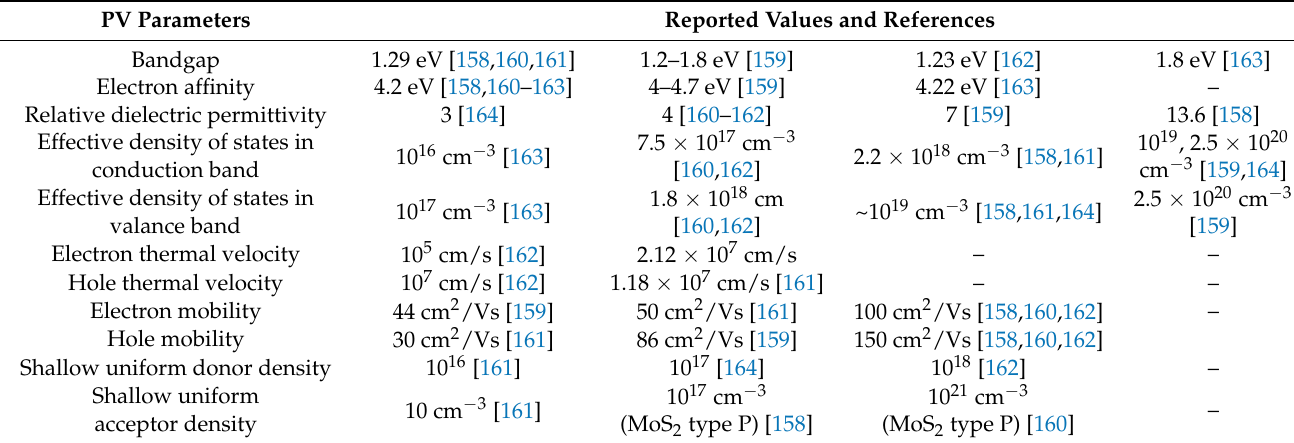
Table 8. A survey of the physical parameters of MoS 2 used for the simulation of photovoltaic applications. PV